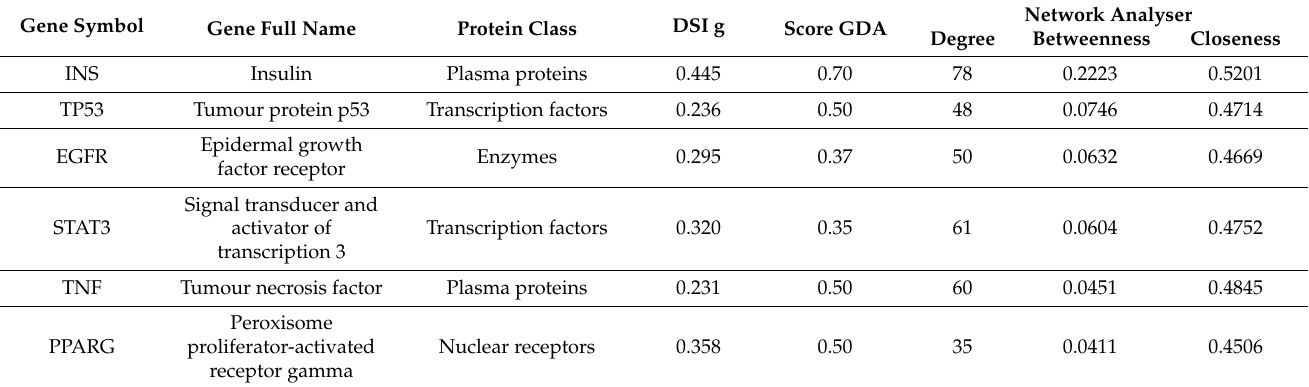
Table 1. Important hub genes associated with